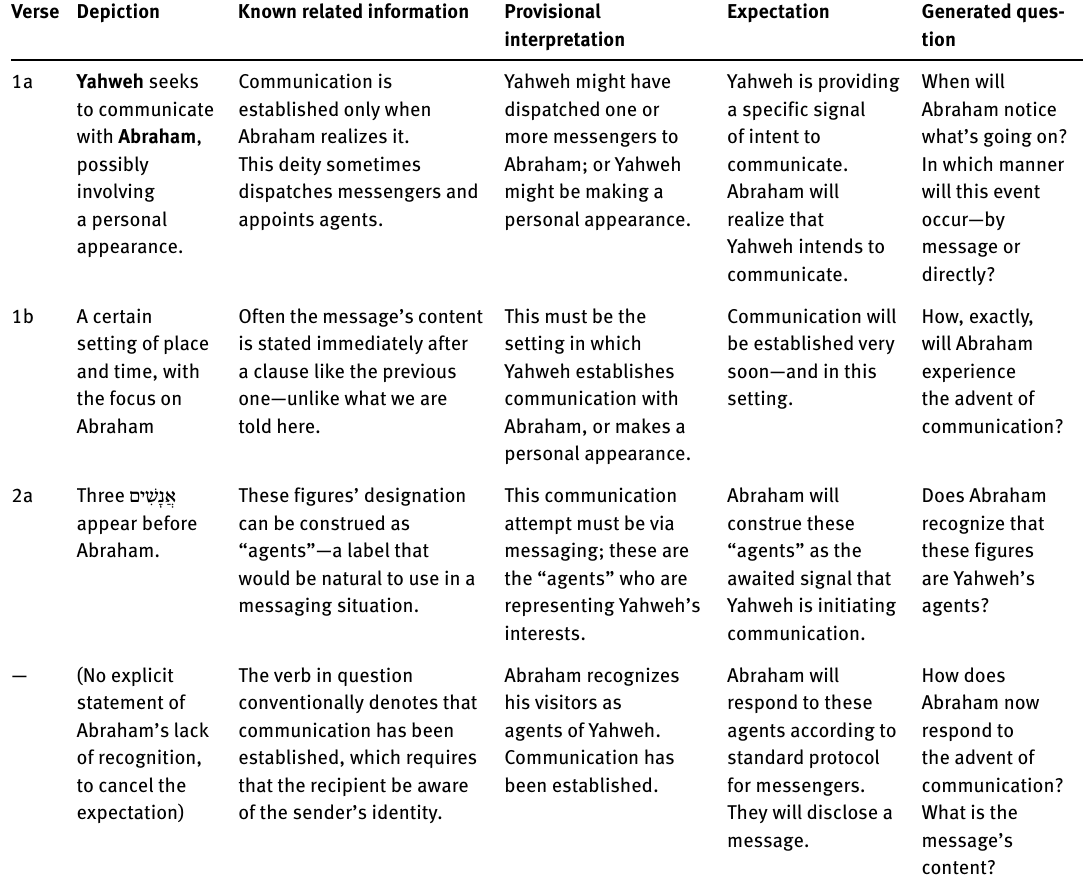
Table 1. Schematic Summary of the Parser’s Processing, as the Story Unfolds Verse Depiction Known related information Provisional